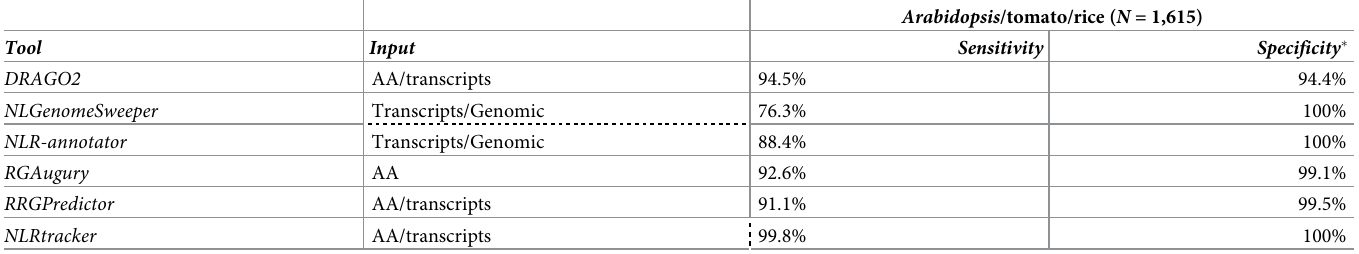
Table 2. Extraction of NLRs from the Arabidopsis , tomato, an d rice RefSeq